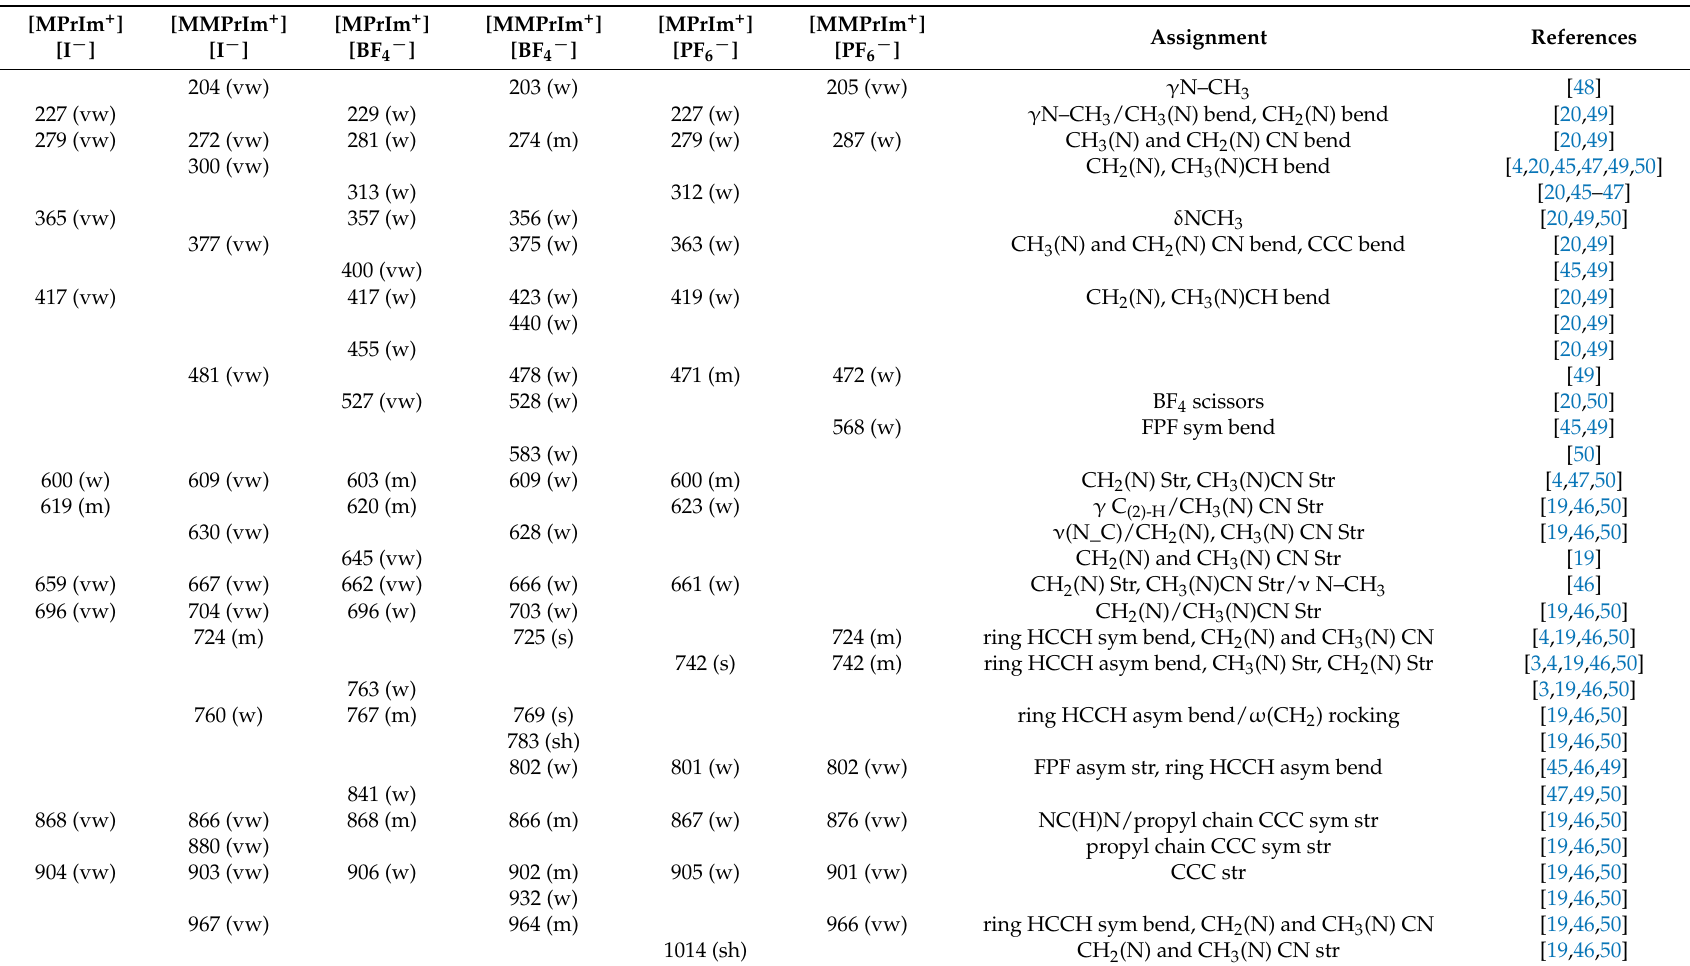
Table A2. Observed FT-Raman bands and their tentative assignment of [1-MPrIM+][I − ], [1,2-DMPrIM+][I − ], [1-MPrIM+][BF 4 − ], [1,2-DMPrIM+][BF 4 −